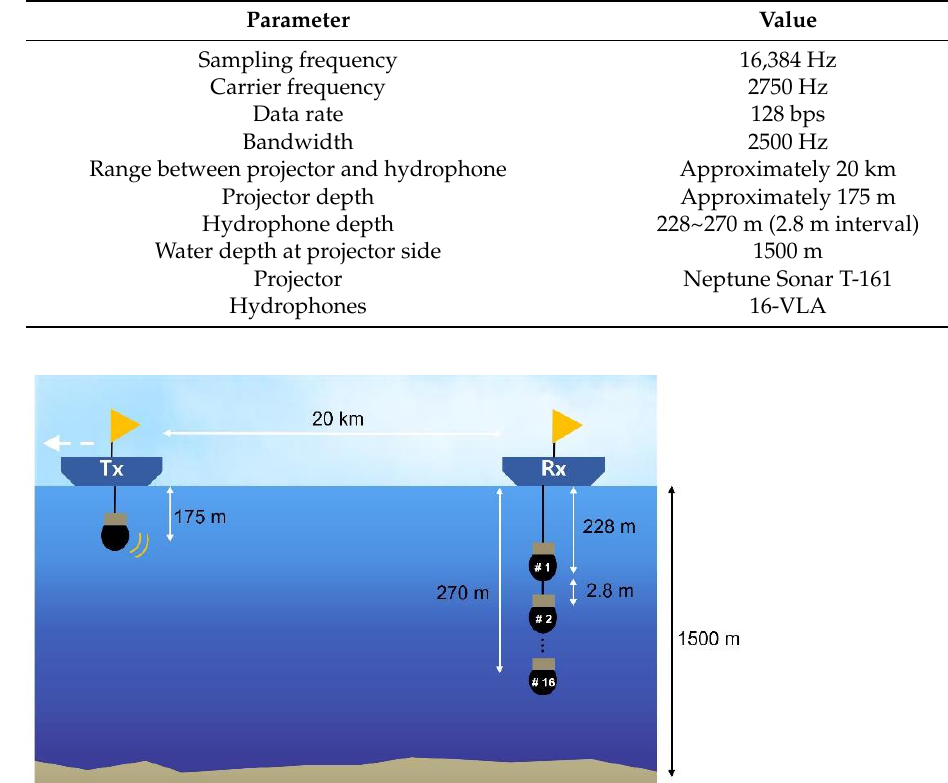
Table 4. Parameters for the sea trial.